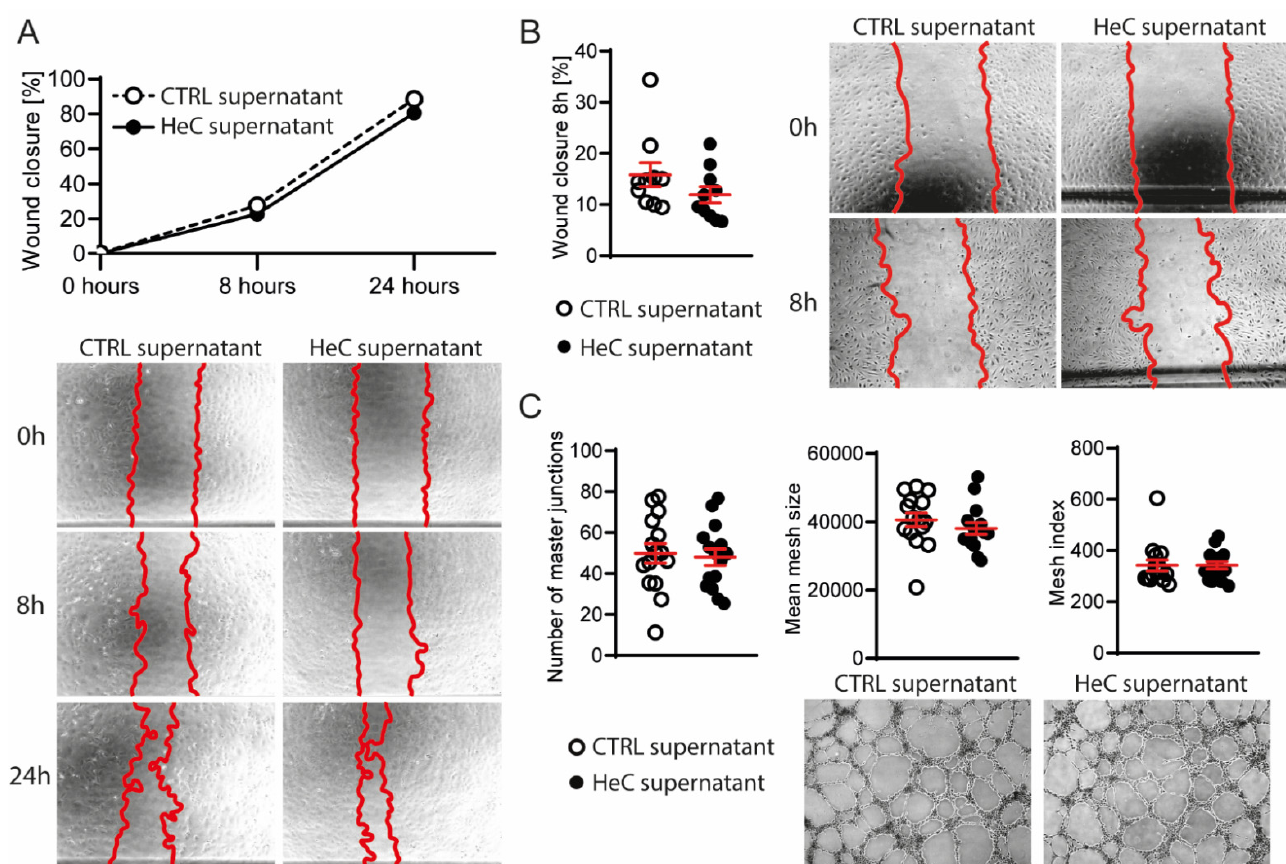
Figure 3. Effect of HeC is not transferred to naïve fibroblast or endothelial cells via soluble factors ; ( A ) Migration of naïve NRCF cells after transfer of CTRL or HeC NRCF supernatant with representative images 0, 8 and 24 h after scratch with 5 × magnification; ( B ) Migration of HUVEC-TERT2 treated with CTRL or HeC NRCF supernatant with representative images 0 and 8 h after scratch with 5 × magnification; ( C ) In vitro angiogenesis of HUVEC-TERT2 treated with CTRL or HeC NRCF supernatant with representative images 6 h after treatment with 5 × magnification. Number of master junctions represent the number of nodes, mean mesh size represent the mean size of the meshes, Mesh index represents the mean length of the branches. n = 4–15. Results are represented as mean ± SEM.